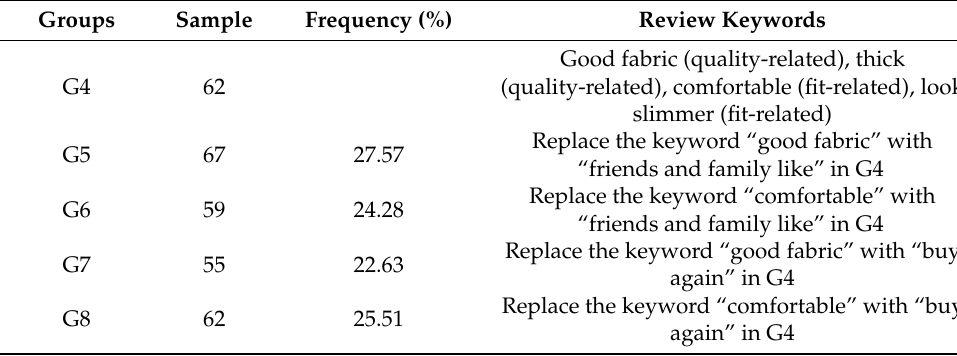
Table 10. Number of samples in different